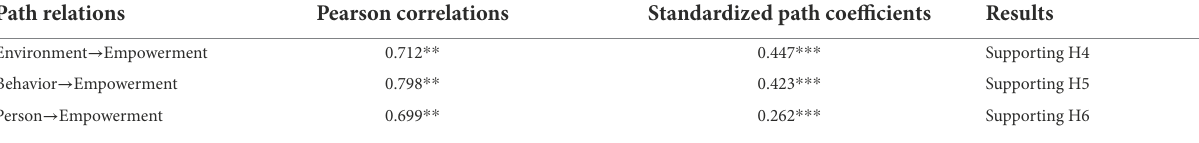
TABLE 5 The relationship coefficients of related path and the hypothesis